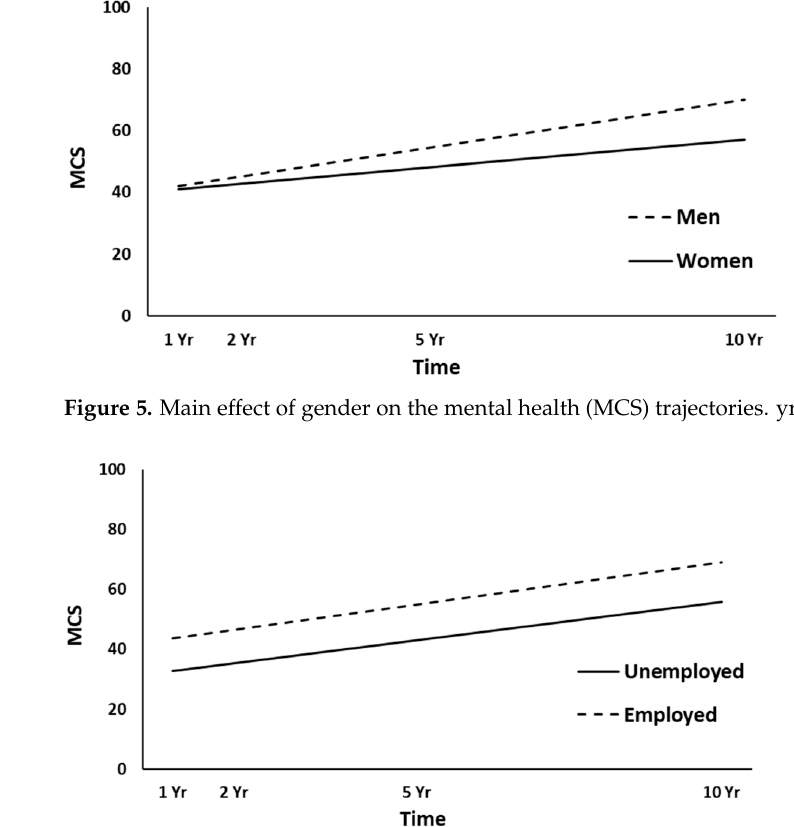
Figure 6. Main effect of employment at admission on the mental health (MCS) trajectories. yr, year.